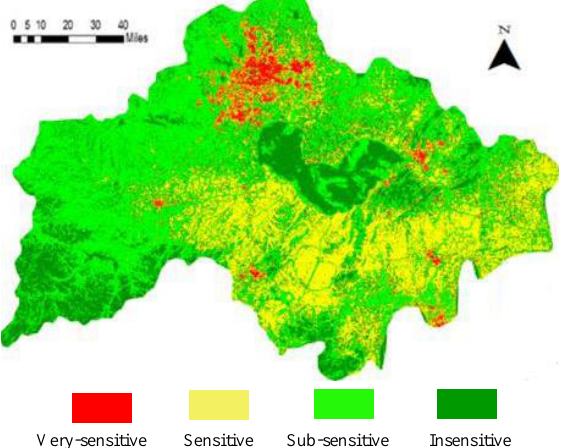
Figure 5 Chaohu ecological sensitivity evaluation